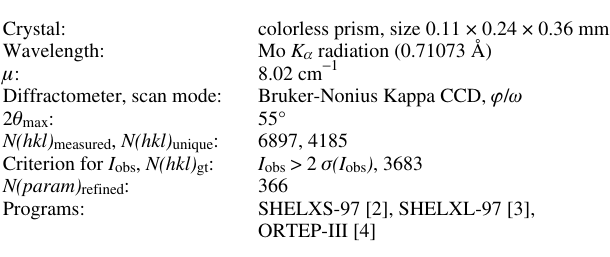
Table 1. Data collection and handling.